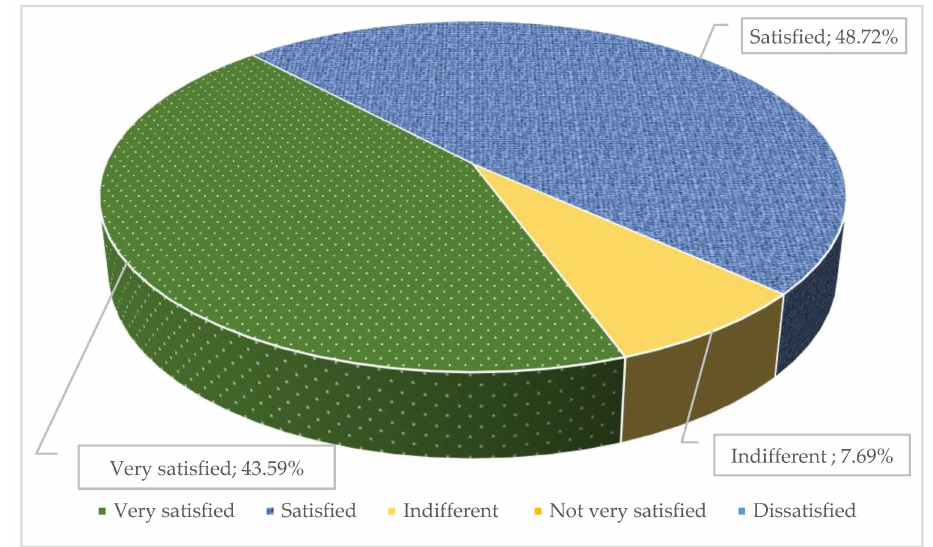
Figure 12. Level of developer satisfaction when using